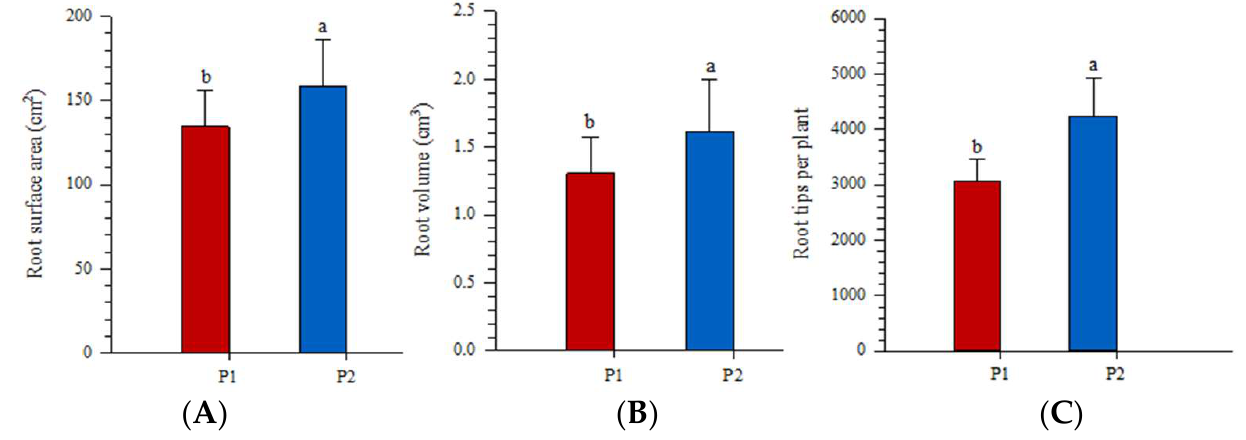
Figure 5. Effects of P addition on root surface area ( A ), root volume ( B ) and root tips ( C ). Bars with